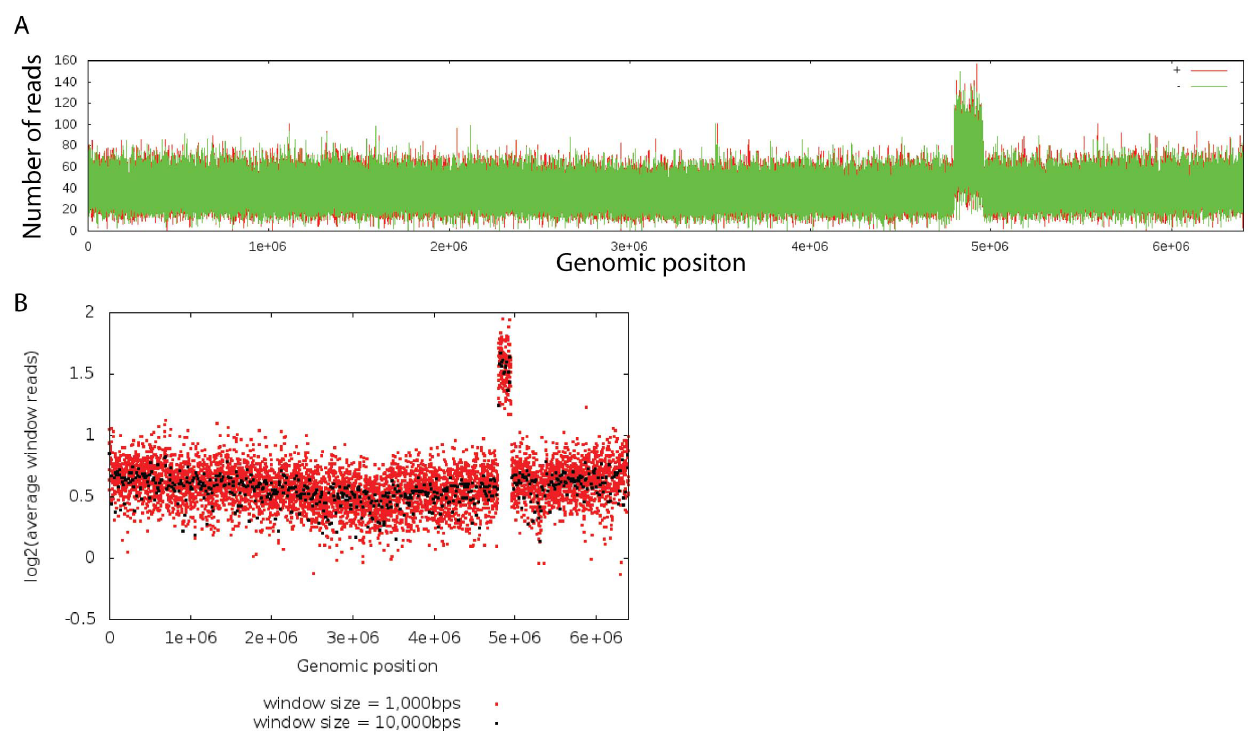
Figure 1. Whole genome sequencing shows a 165 kb duplication in Pst DC3000. The Pst DC3000(H0457) isolate used to generate the reference sequence described by Buell et al., 2003 was re-sequenced using Illumina short read methods. A. Alignment of the observed reads to the reference sequence indicated higher than expected read coverage between genomic coordinates 4790733..4955867. This profile shows the absolute read depth coverage for the Pst DC3000 chromosome. Note that the origin of replication ( ori ) is on the left and right ends, and the terminus ( ter ) is in the center, close to position 3 6 10 6 . Red and green lines show the number of reads matching the positive or negative strand of the chromosome, respectively. B. Copy number analysis indicated that read coverage was increased by two-fold above the expected average. For a complete list of all 1000 bp regions with altered read coverage, see Table S2. The ori-ter sequence content gradient is also visible, with more sequence coverage at regions closer to the ori as would be expected in growing cells with multiple rounds of replication proceeding concurrently. The region with anomalous coverage is oriented so that one end is closer to the ter . We refer to the ter -proximal end of the duplicated sequence as the left end and the ter -distal end as the right